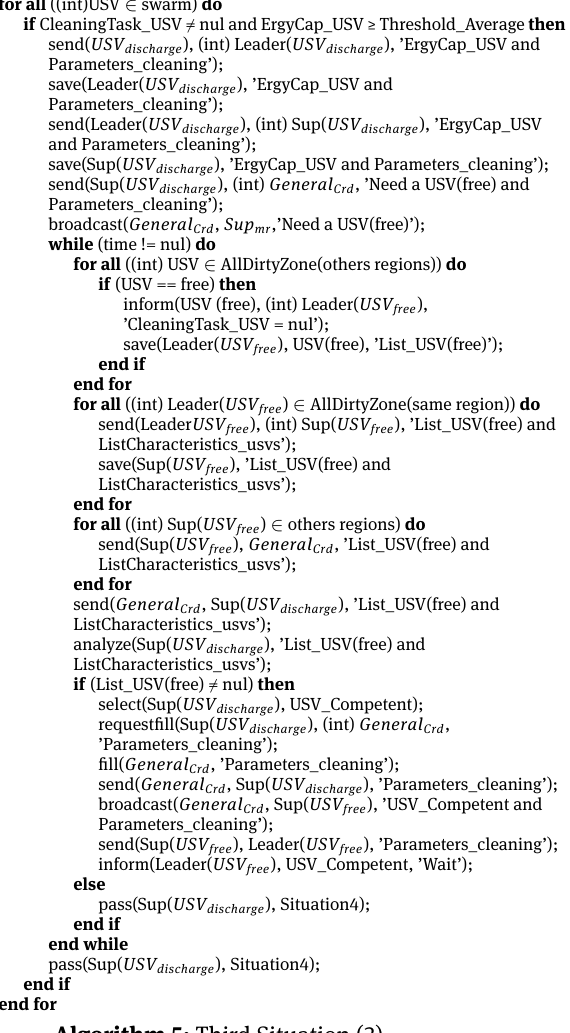
Algorithm 5: Third Situation